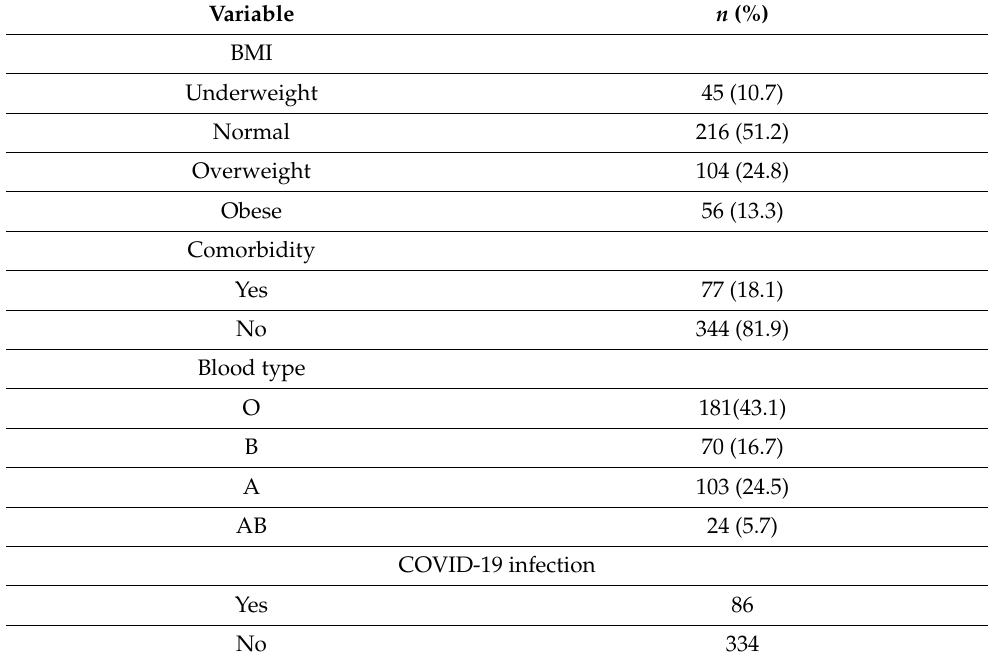
Table 2. Medical history.